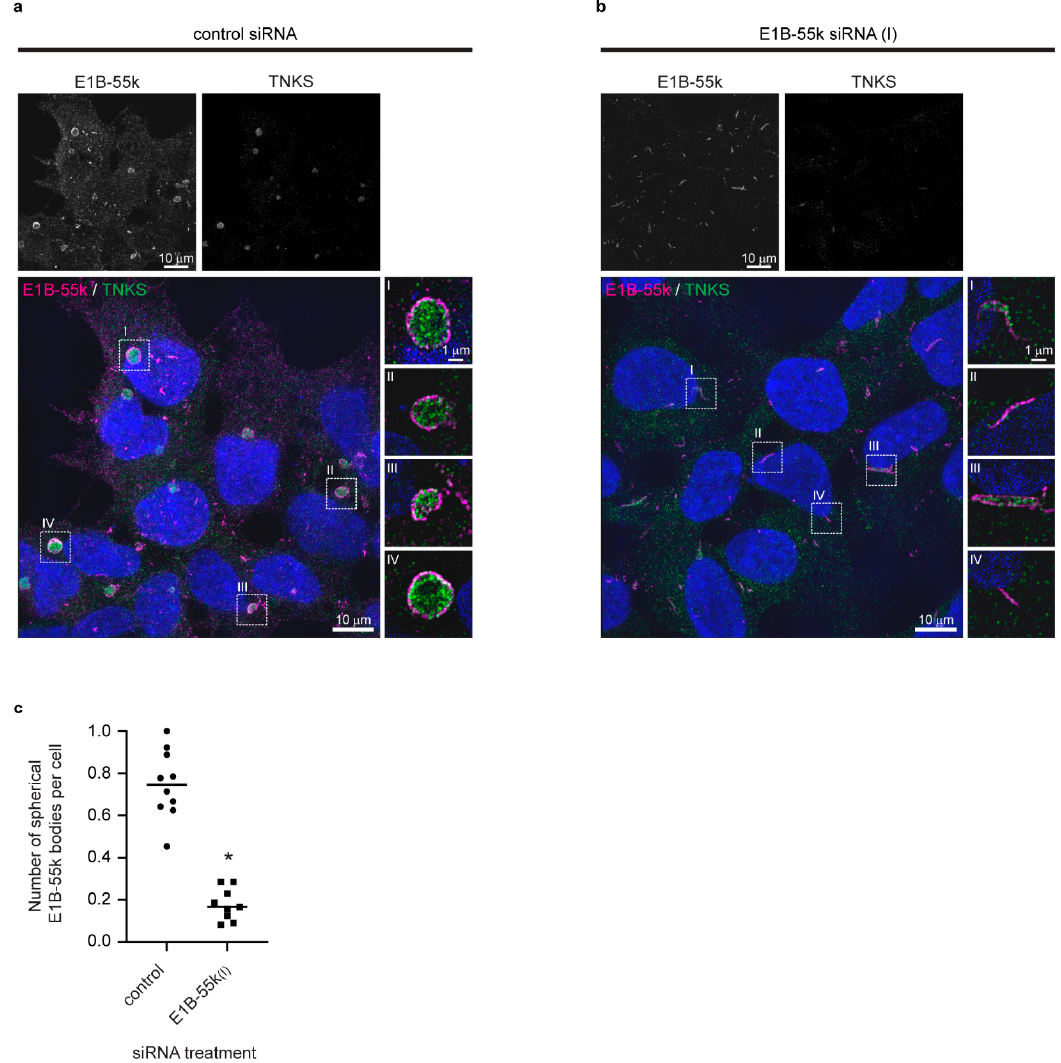
Figure 3. The cytoplasmic aggregates are organized spherical structures which are enclosed by a narrow layer of adenoviral E1B-55k protein. Reduction of E1B-55k protein levels causes the disassembly of the spherical aggregates. Representative SIM images of HEK293 cells treated with ( a ) control or ( b ) E1B-55k siRNA. Upper rows display single-channel images of E1B-55k and TNKS as indicated. In the merged color images, nuclear counterstaining is shown in blue, and enlargements of the stippled boxes are shown to the right (single Z plane). ( c ) Quantification of mean number of cytoplasmic spherical aggregates per cell in control and E1B-55k siRNA-treated cells. Each point represents the mean number of cytoplasmic aggregates per cell in one microscopic view field. For each siRNA treatment, 10 random view fields were quantified. The asterisk indicates a significant difference between control and E1B-55k siRNA-treated cells ( p < 0.0001, unpaired t -test).